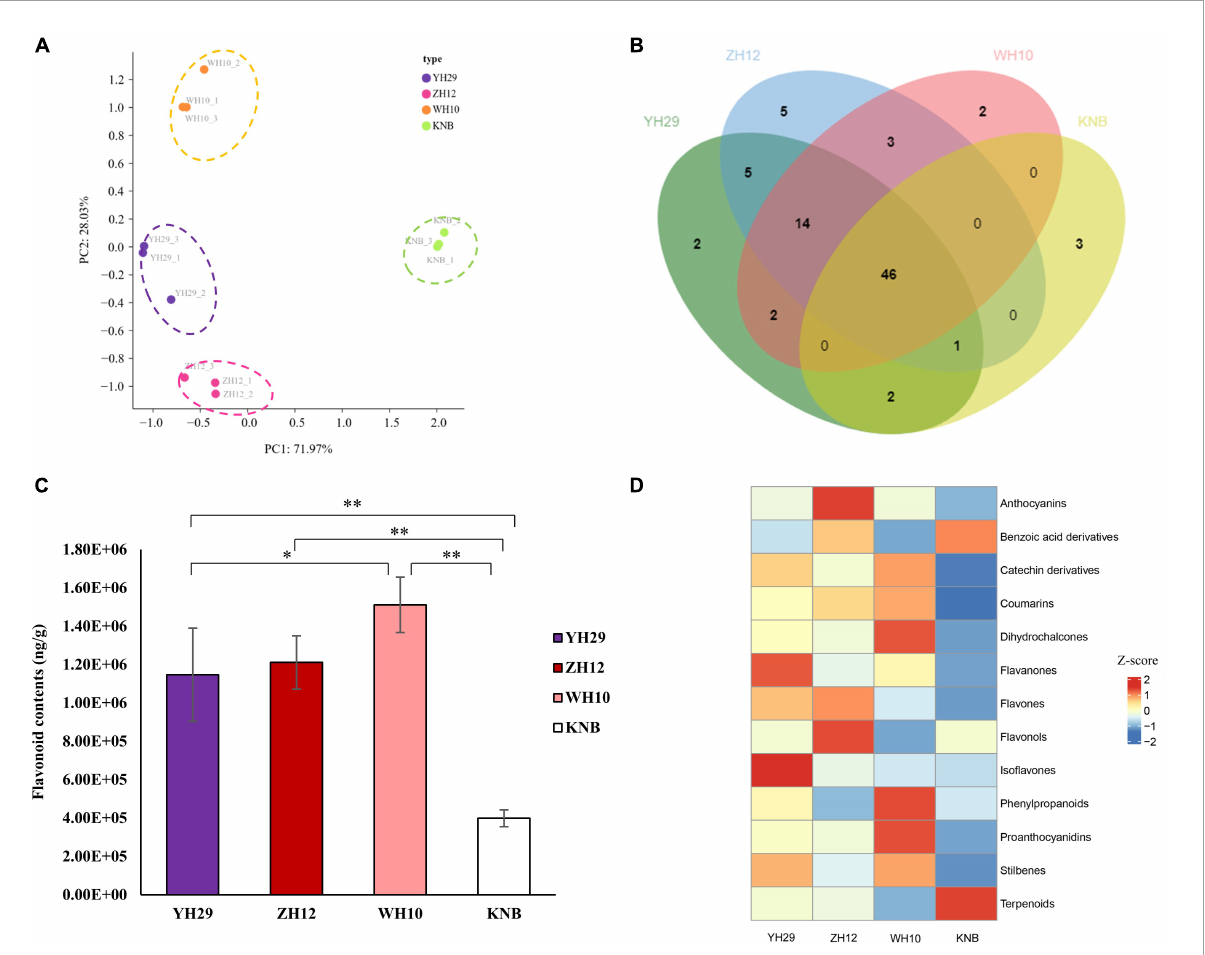
FIGURE2 Extractive composition differences in type and content among the four samples. (A) Principal component analysis (PCA) score plots for metabolites in four types of peanut testa based on LC-MS/MS. (B) Distribution of the 85 flavonoids in the different colored testa. (C) The total content of flavonoids detected in the four samples. (D) The comparison of the relative contents of different type of flavonoids in the four samples. Row data is normalized into